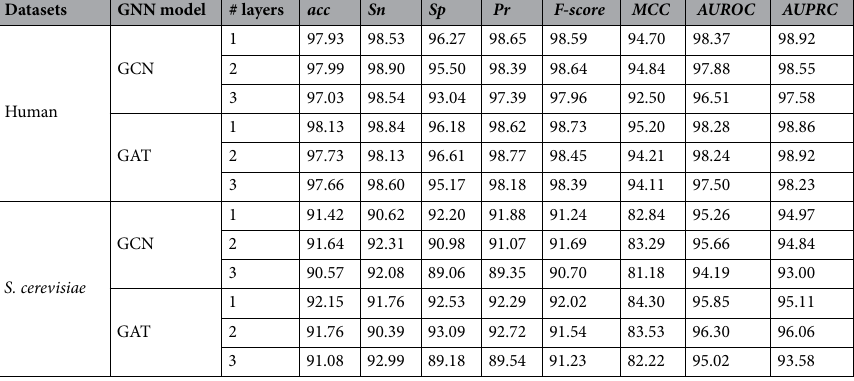
Table 6. The results of GNN variants using LSTM-based LM node features with different number of layers for PPI datasets.